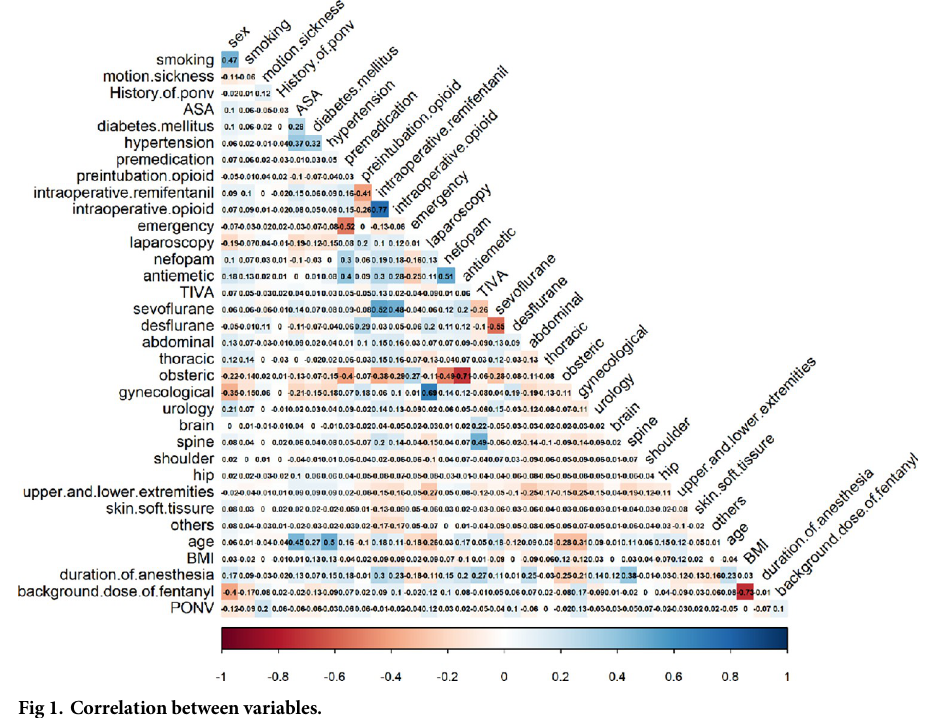
Fig 1. Correlation between variables.